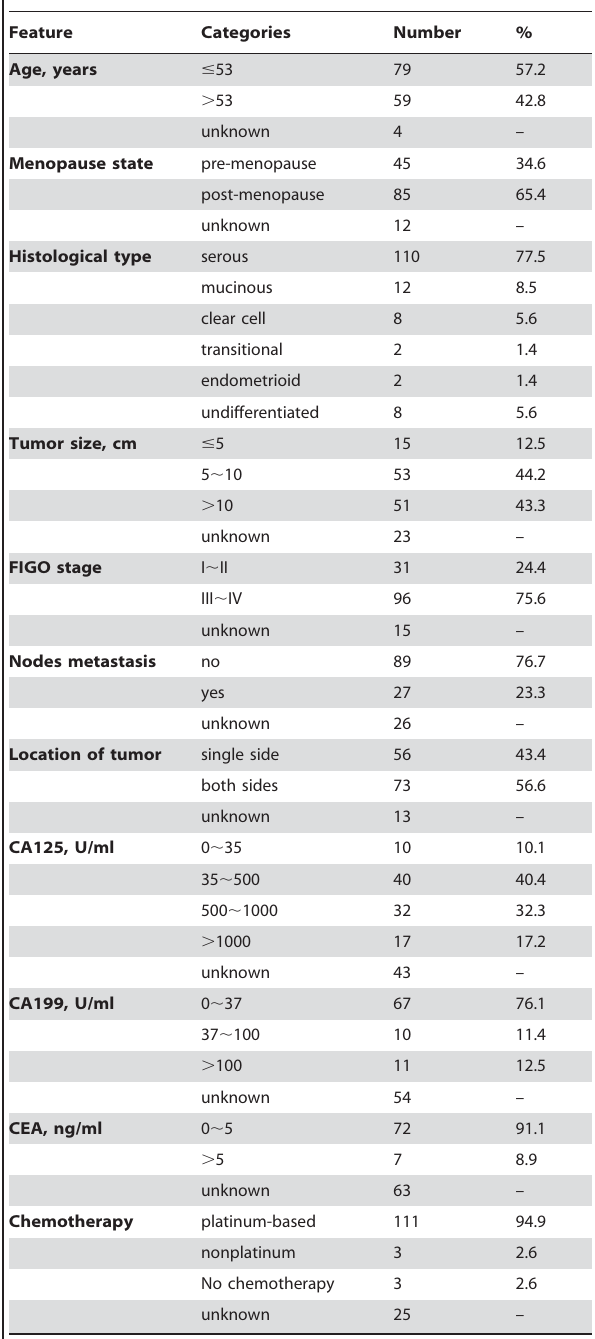
Table 1. Patient